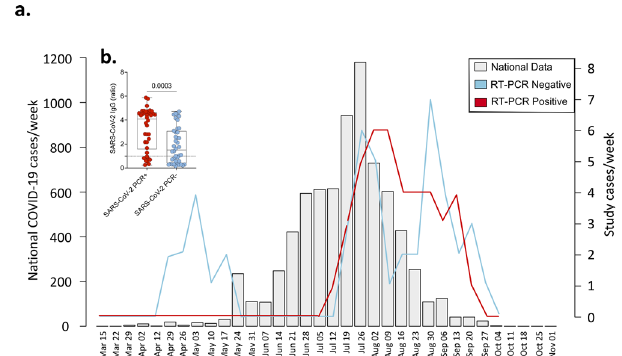
Fig. 1 Study recruitment timeline and SARS-CoV-2 diagnosis. a Suspected and SARS-CoV-2 RT-qPCR-con fi rmed COVID-19 patients recruited at Queen Elizabeth Central Hospital, Blantyre (positive (red) and negative (blue)) reported as cases/week compared to the national data (light grey). National data include SARS-CoV-2 RT-qPCR-con fi rmed symptomatic and non-symptomatic COVID-19. b SARS-CoV-2 Spike protein 2 (S2) and nucleoprotein (NP) IgG antibodies in PCR-negative and -positive individuals. The data are reported as the ratio of OD in the test samples to the assay threshold control. For all boxplots, box boundaries correspond to 25th and 75th percentiles; whiskers extend to a maximum or minimum greatest value. Data were analysed using Mann – Whitney test, two-sided (PCR positive, n = 38; PCR negative, n = 45). SARS-CoV-2 severe acute respiratory syndrome coronavirus 2, COVID-19 coronavirus disease of 2019, PCR polymerase chain reaction, IgG immunoglobulin, SARI severe acute respiratory infection. Source data are provided as a Source Data fi ( n = 25) and PCR − /IgG − SARI ( n = 21) participants (Fig. 1b). In addition, we recruited 25 ambulatory healthy volunteers. Table 1. To verify the speci fi city of the ELISA assay, we tested pre-COVID-19 pandemic historical sera from individuals with other coronaviruses, malaria convalescent sera, sera from people living with HIV and sera from asymptomatic HIV-uninfected adults, and found a speci fi city of 8/132 (94% [CI 91 – 97]) (Sup- plementary Fig. 1). We also tested antibodies in a WHO- recommended NIBSC Pro fi ciency Plasma Panel (20/120, 20/122, 20/124, 20/126, 20/128 and 20/130) and found 100% concordant results (Supplementary Fig. 1). Hospitalised individuals with PCR-con fi rmed COVID-19 were signi fi cantly older (median 50 [PCR + ] vs. 34 [PCR − /IgG + ] vs. 41 [PCR − /IgG − ], p = 0.017), more likely to have received dexamethasone (63% vs. 4% vs. 0%, p < 0.001) and more likely to have received a beta-lactam antibiotic (78% vs. 52% vs.48%, p = 0.022) compared to the PCR − /IgG + and PCR − /IgG − SARI participants. Additionally, PCR-con fi rmed COVID-19 participants were more likely to survive (93% vs. 80% vs. 57%, p = 0.004) with increased hospital length of stay (median days 8 vs. 6 vs. 6, p = 0.028) compared to the PCR − /IgG + and PCR − /IgG − SARI partici- pants. PCR − /IgG + SARI participants also tended toward longer times from symptom onset to hospital admission compared to PCR-con fi rmed COVID-19 participants (median 6 vs. 4 days)